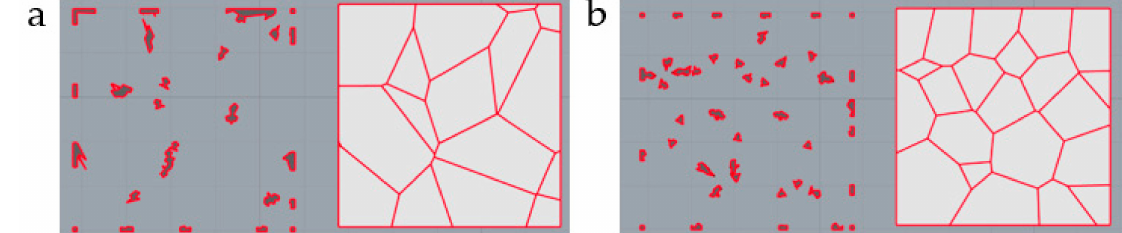
Figure 10. Z-axis sections of the beam structure in structure 3: ( a ) Section near the middle of the structure (The left is the section of support beams and the right is the section of Voronoi polyhedrons); ( b ) Section near the thin plate.